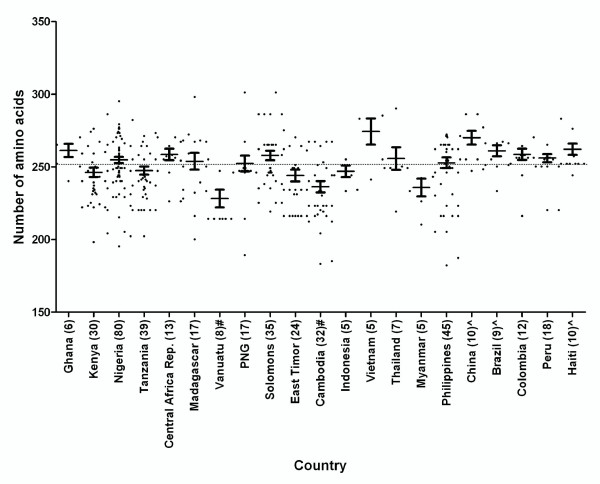
The length of PfHRP2 (number of aa) in countries with ≥5 samples. Numbers in brackets indicate the number of samples. The dotted line indicates the global mean. ^ The mean number is significantly higher than the global mean (p < 0.05); # the mean number is significantly lower than the global mean (p < 0.05)